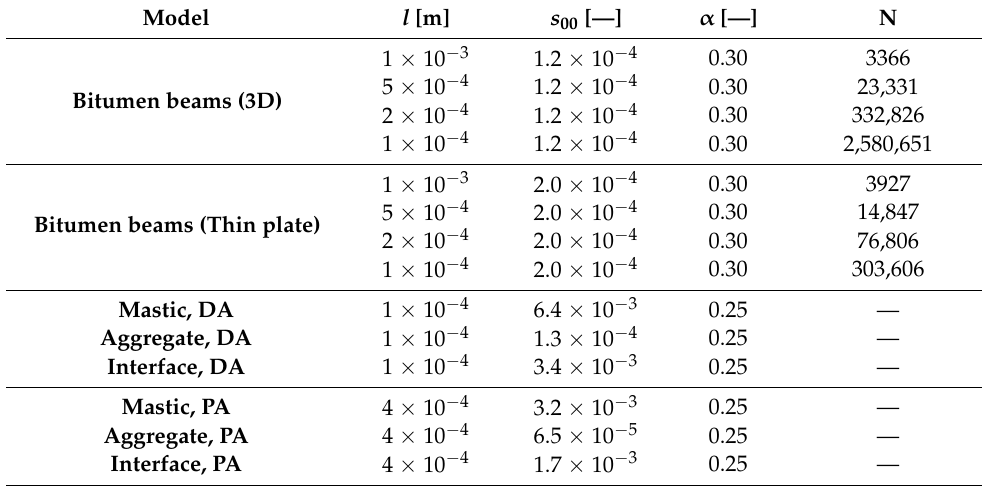
Table 6. Peridynamic parameters used in the simulations. s00 is defined by Equation (9). Model